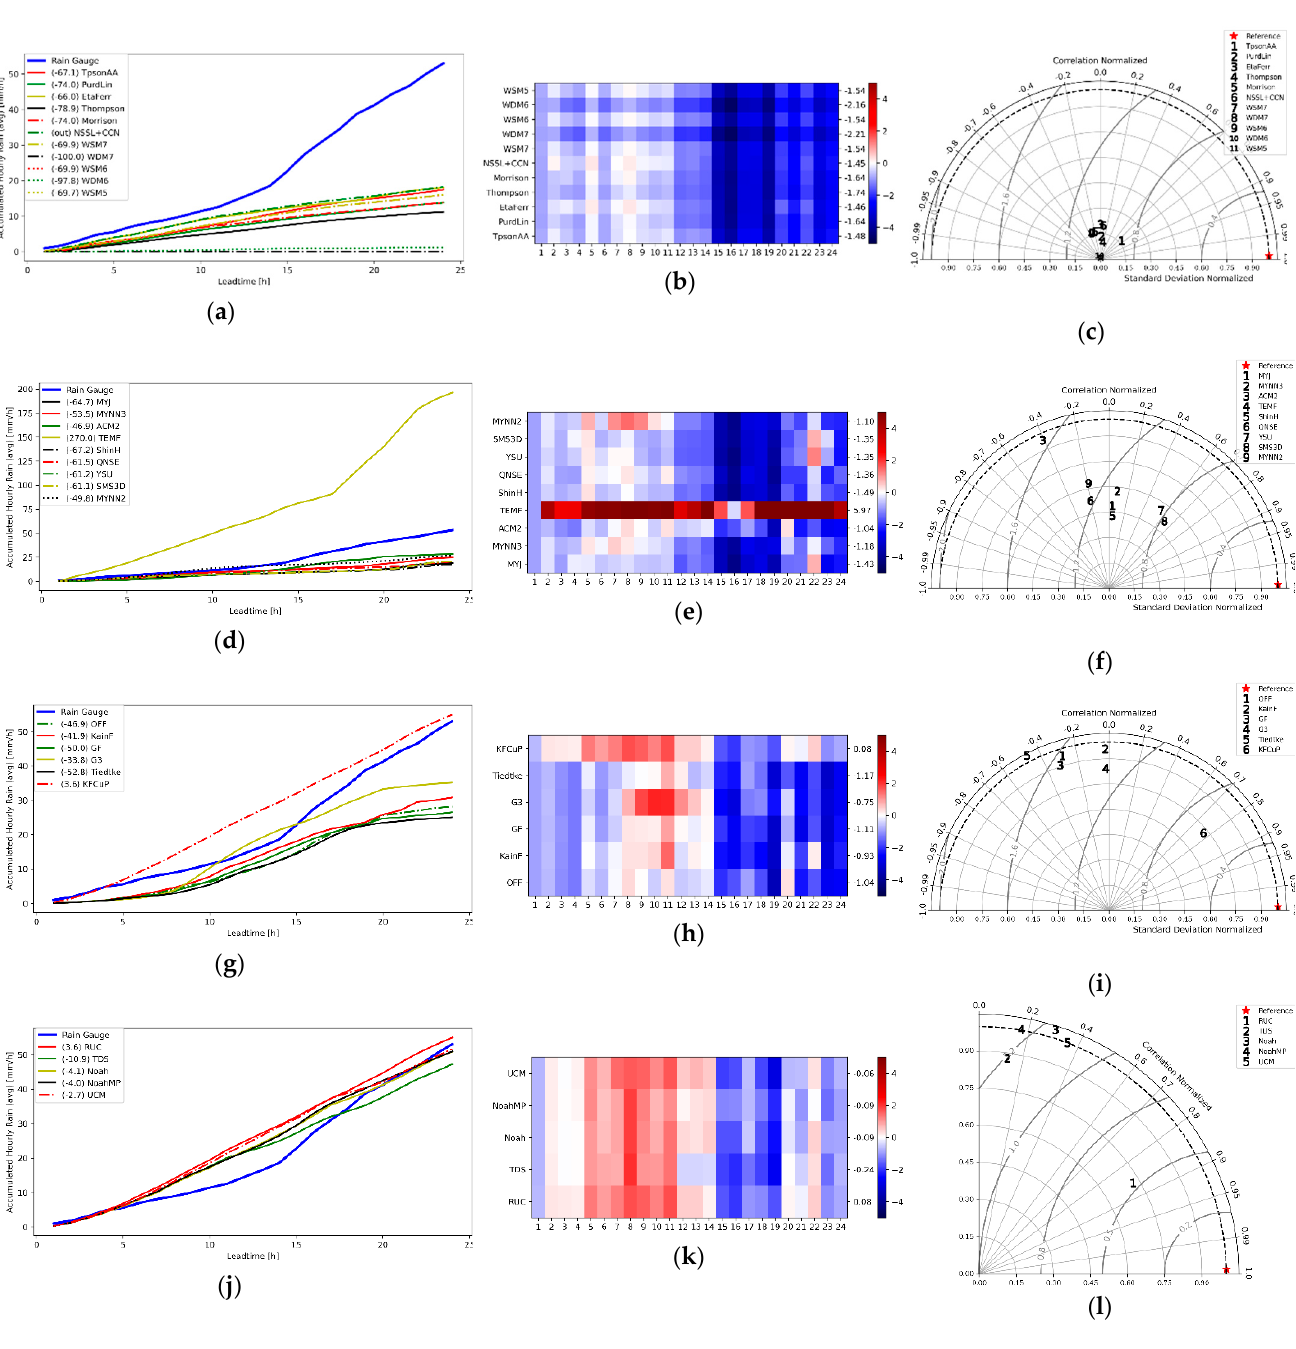
( l ) Figure 4. Analysis of the model settings for event 1: ( a − c ) microphysics settings, ( d − f ) the planetary boundary layer, ( g − i ) cumulus, and ( j − l ) surface parameterizations. The column on the left com- pares the average hourly accumulated rainfall at the rain gauges with the rainfall generated by the model according to the settings under analysis; inside the legend are the relative errors (REs) accu- mulated over 24 h for each configuration. The middle column shows the average hourly bias and on the secondary axis the average period bias. The column on the right shows the Taylor diagram. The simulations for event 2 were performed between 20170720 00UTC and 20170721 00UTC and totaled 30 runs. The three best MPHs were NSSL + CCN, EtaFerr, and